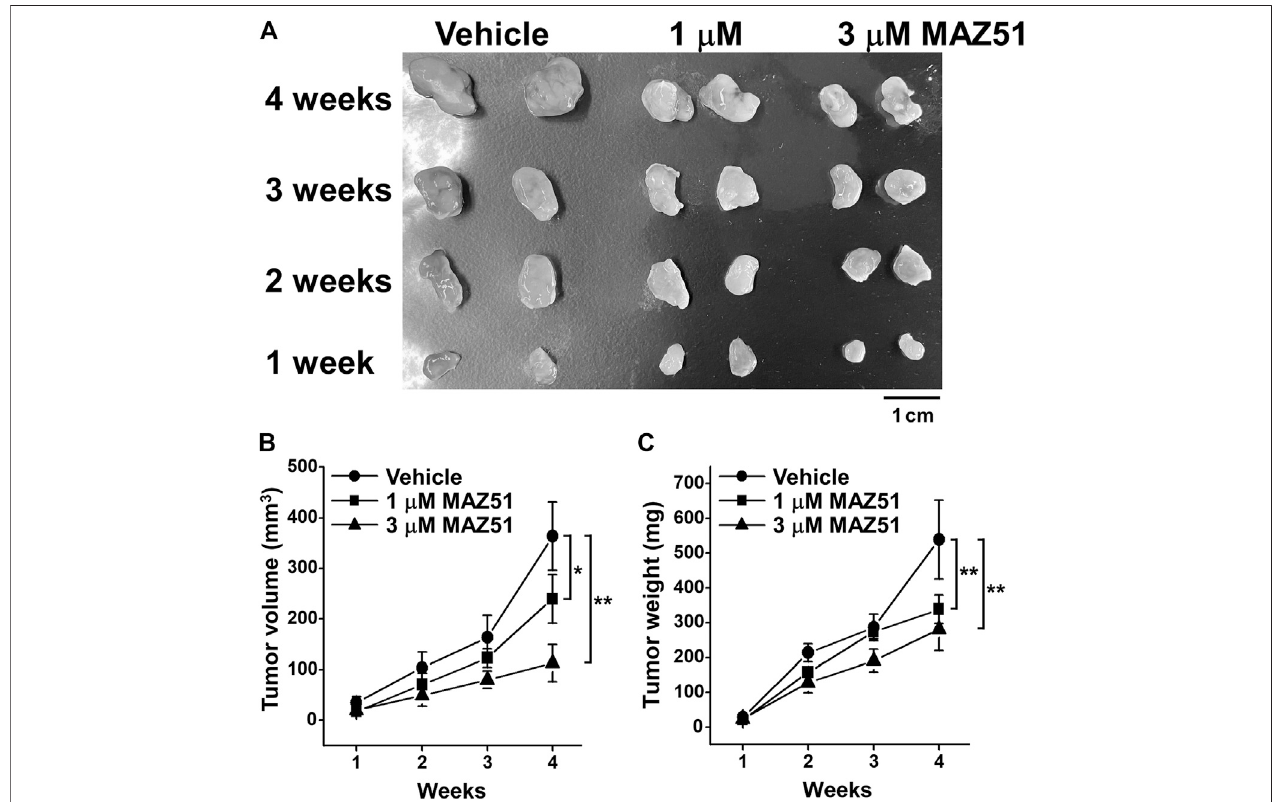
FIGURE9| InhibitionofthetumorgrowthofPC-3cellsbyMAZ51.TheeffectsofMAZ51onthetumorgrowthofhumanprostatecancerPC-3cellswereexamined in a xenograft mouse model. (A) Representative tumors after the treatment with vehicle (0.1% DMSO), 1, or 3 μ M MAZ51 for 1 – 4 weeks. (B,C) Tumor volumes (B) and weights (C) afterthetreatmentwithvehicleorMAZ51for1 – 4 weeks( n (cid:1) 5 – 6).NotethattheVEGFR-3kinaseinhibitionbyMAZ51effectivelyblockedthetumorgrowthof prostate cancer in ex vivo model. Data are presented as means ± S.D. * p < 0.05, ** p < 0.01 vs. vehicle control (non-parametric Mann-Whitney U-test).